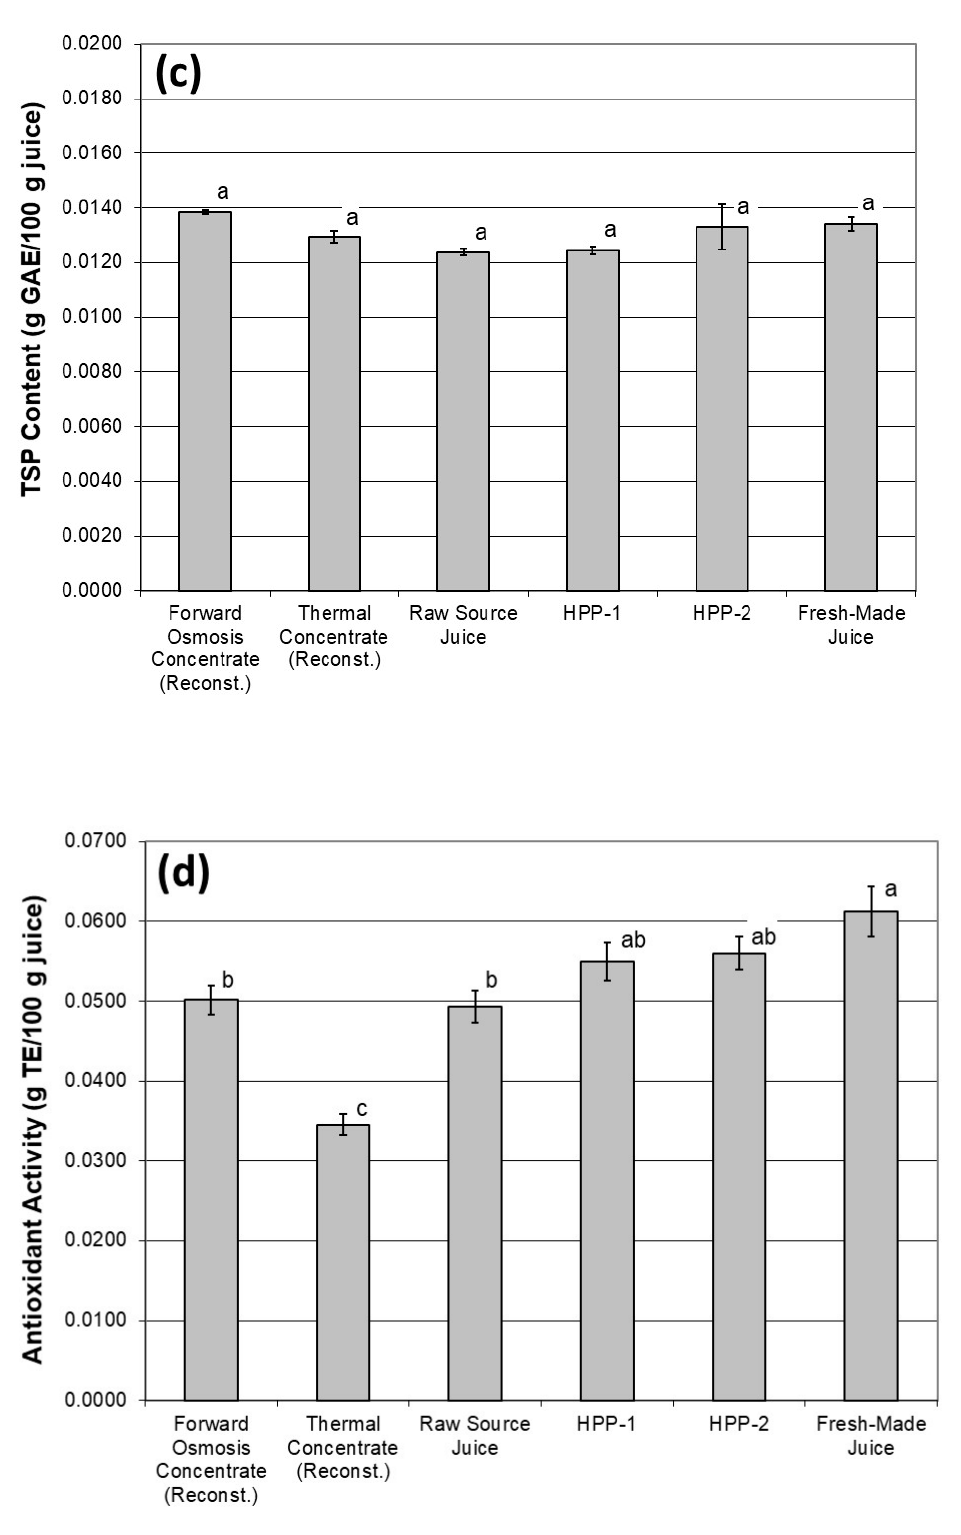
Figure 2. Effect of juice type on lycopene content ( a ), citrulline content ( b ), total soluble phenolics (TSP) content ( c ), and antioxidant activity ( d ) of watermelon juice. For concentrates, values shown are for the reconstituted (8× diluted) samples to enable comparison with single-strength juice. Error bars indicate ±1 standard error of the mean. HPP = high pressure processed, GAE = gallic acid equivalents, and TE = Trolox equivalents.